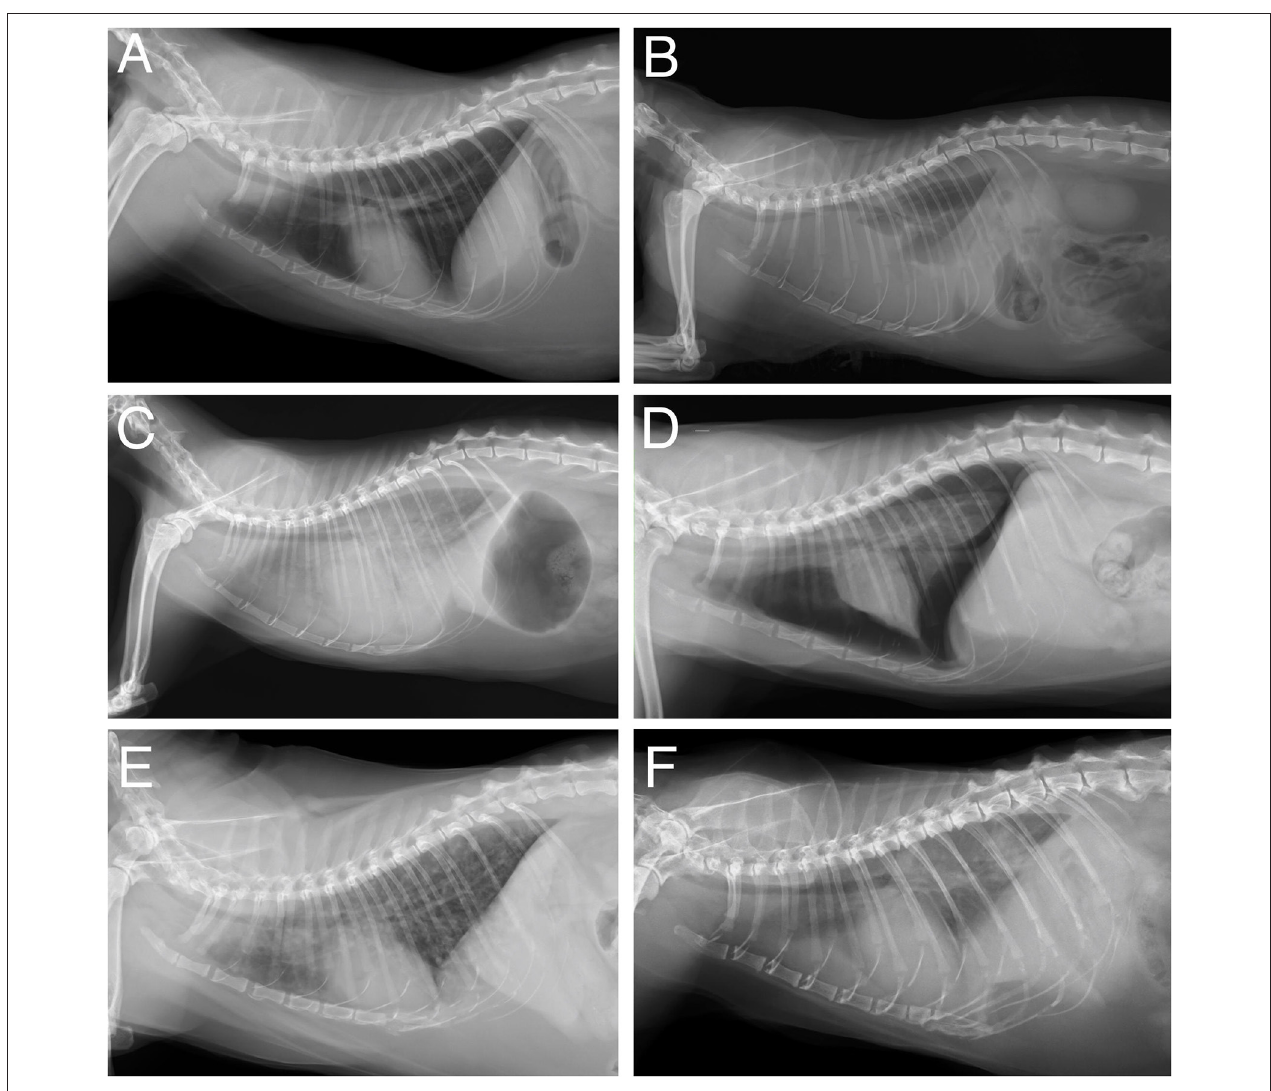
FIGURE 1 | Example images of the radiographs used to train the CNN. (A) No finding; (B) pleural effusion; (C) cardiomegaly, alveolar, and interstitial pattern; (D) pneumothorax and alveolar pattern; (E) bronchial pattern; (F) mass, interstitial pattern, and alveolar pattern.